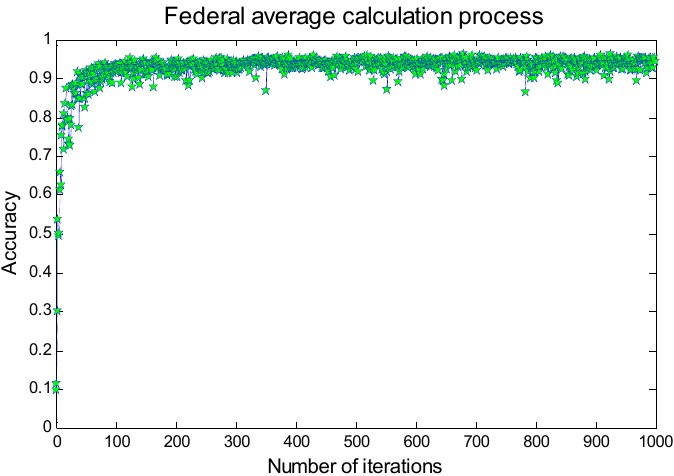
Figure 7. Accuracy variation diagram of 1000 iterations.